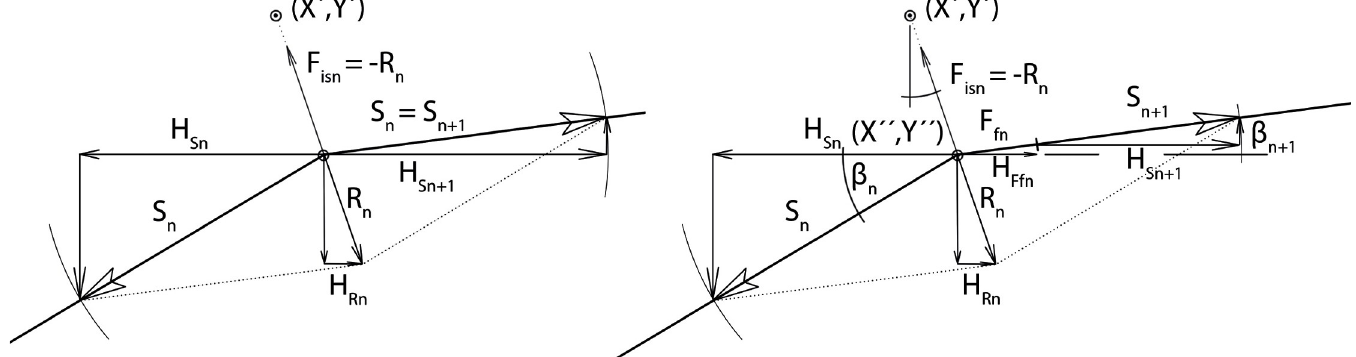
Fig 2. Force diagram at any break of slope (left) and at an intermediate support (right).